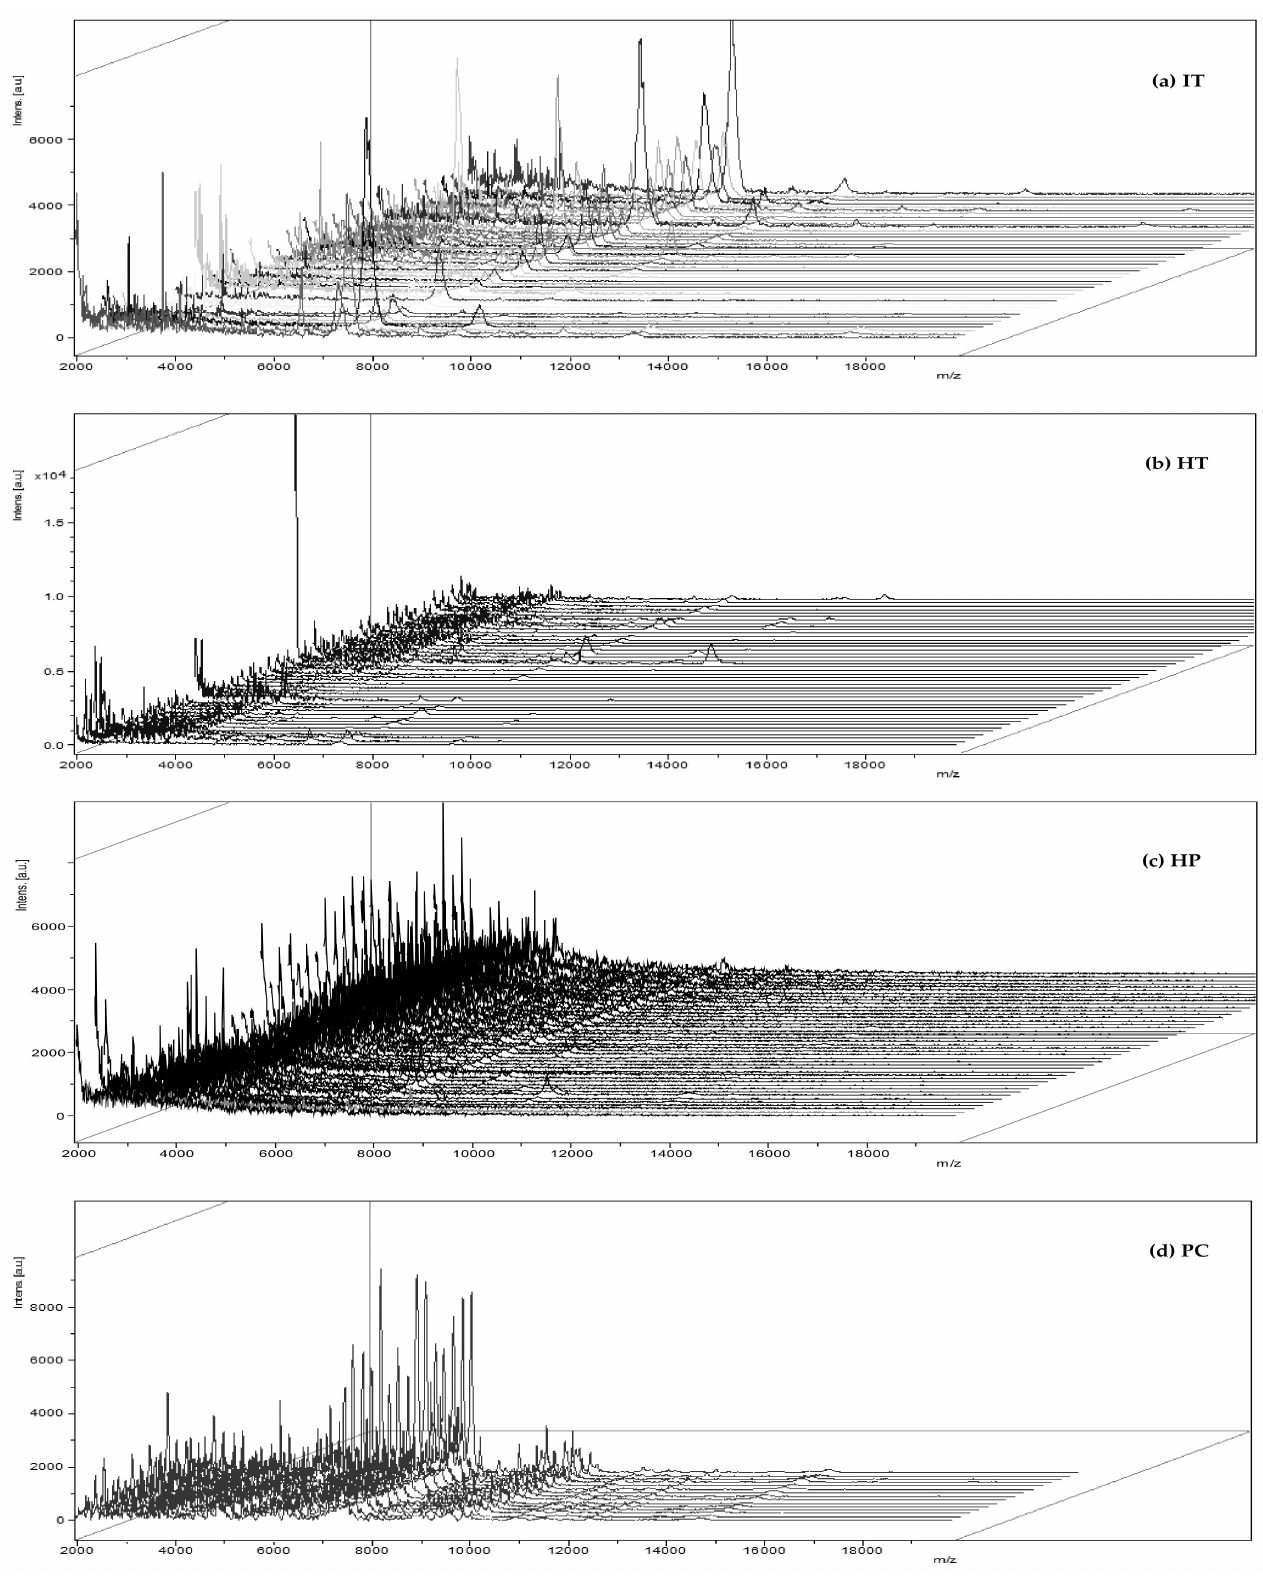
Figure 9. Mass spectra of C. sinensis leafsamples from the field, ( a ) IT, ( b ) HT, and ( c ) HP, and Xcc strains ( d ) PC. IT: canker lesion, HT: healthy tissue, HP: herbicide phytotoxicity, PC: pure culture of Xcc . y -axis: ion intensity. x -axis: mass/charge ( m/z